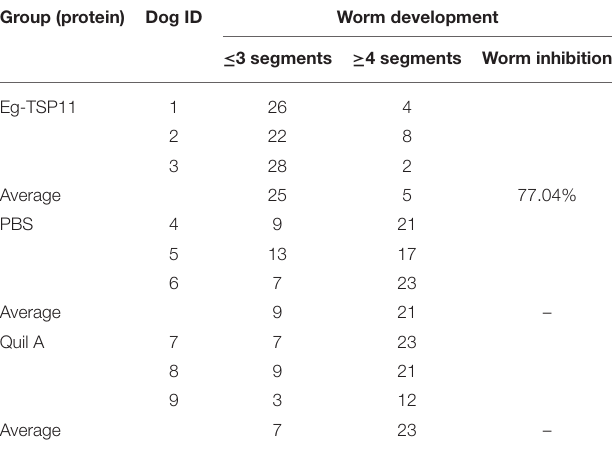
TABLE 1 | Number of Worms in vaccinated dogs after PSC challenge. Group (protein)